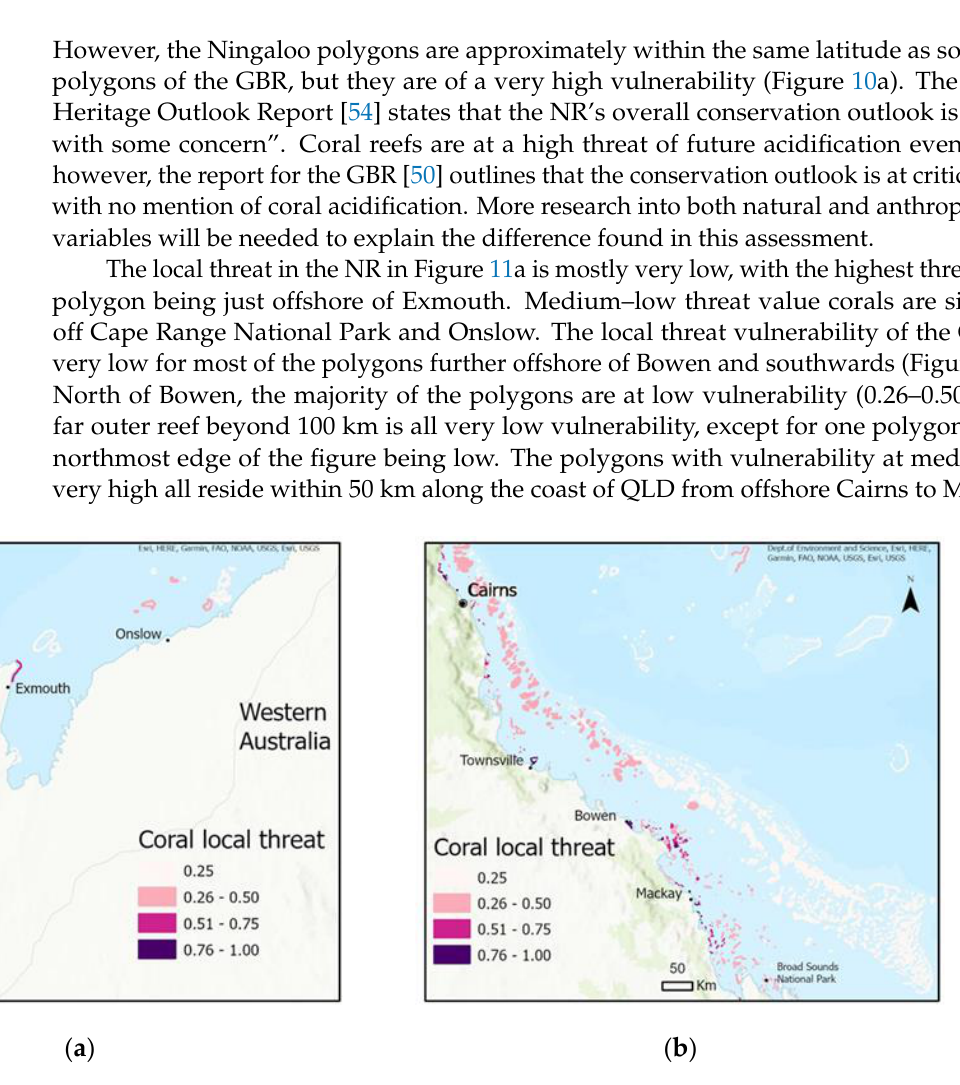
Figure 11. Vulnerability indicator maps of coral local threat in the Ningaloo Reef ( a ) and the southern Great Barrier Reef ( b ). Higher (darker) values denote greater local threat to corals.